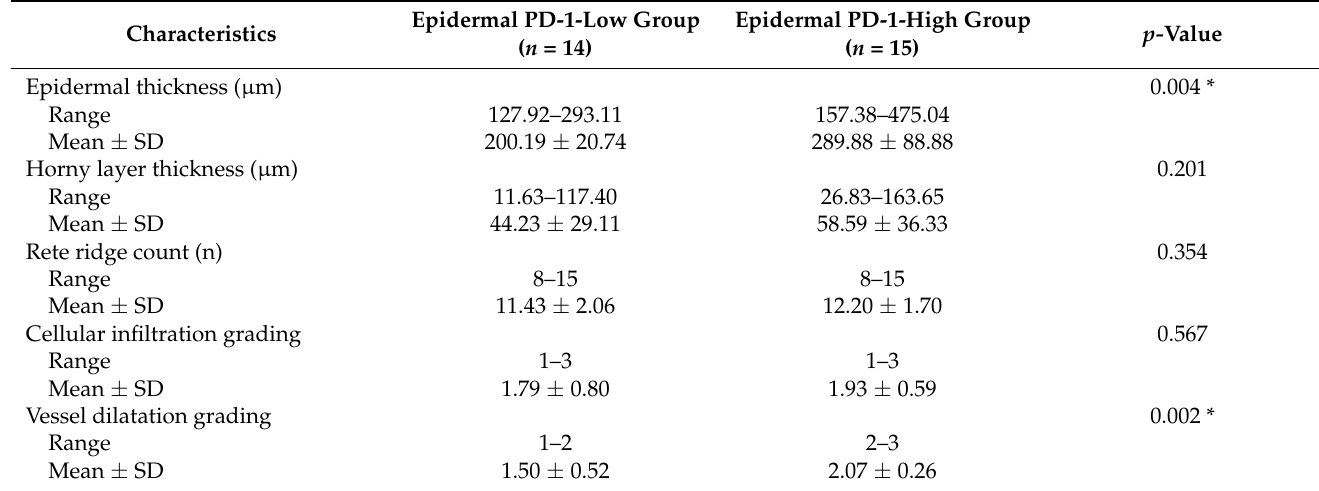
Table 2. Histopathological characteristics of patients with chronic plaque psoriasis according to the epidermal expression level of